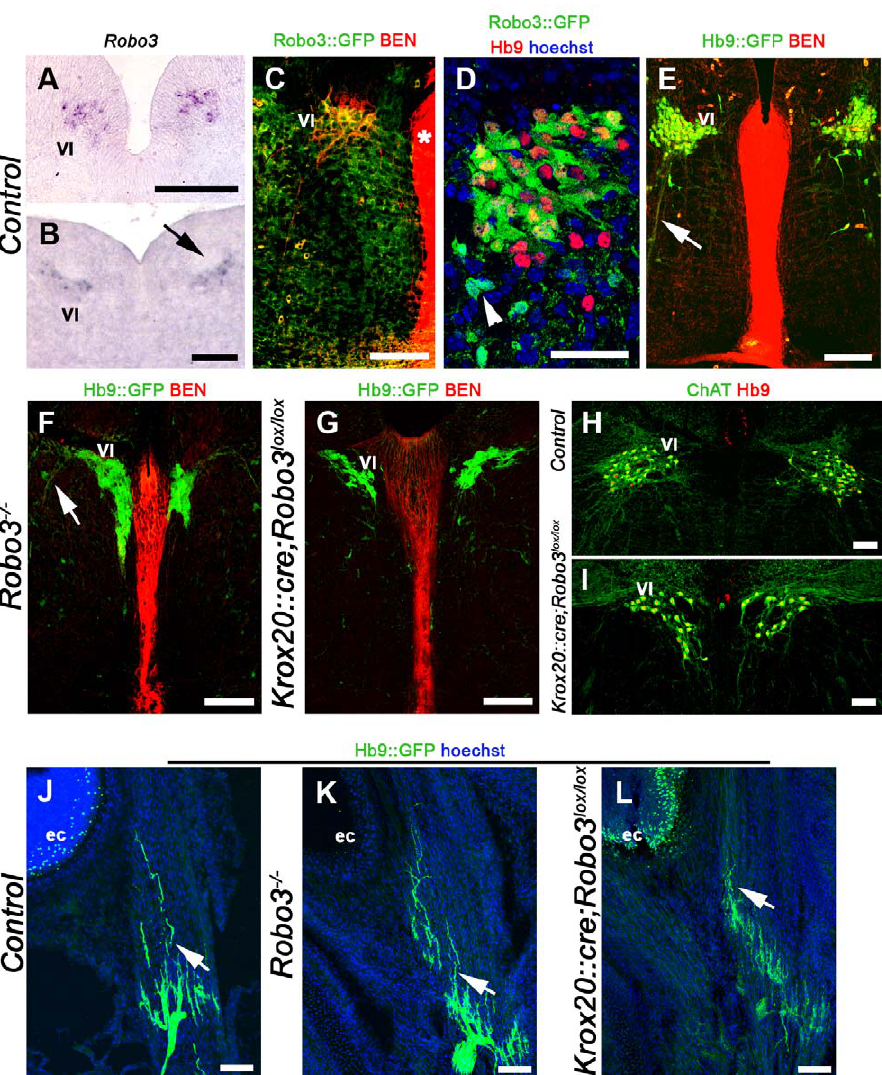
Figure 3. Normal projection of abducens motor axons in Robo3-deficient mice. (A to I) show coronal hindbrain sections at the level of the abducens nucleus. (A and B) Robo3 transcripts are detected in the abducens nuclei of E12 (A) and E14 (B) embryos. The arrow in (B) points to the facial nerve. (C) abducens neurons coexpress BEN and GFP in Robo3 + / 2 E14 embryo. The floor plate (asterisk) also expresses BEN. (D) Hb9/GFP double labeling in E15 Robo3 + / 2 embryo. Note that some GFP + cells (arrowhead) do not express Hb9. (E) abducens neurons (VI) and axons (arrow) express GFP in E14 Hb9::GFP transgenic embryo. (F–I) The abducens nucleus has an abnormal shape and is closer to the floor plate in Robo3 2 / 2 (F) and Krox20::cre;Robo3 lox/lox (G) E14 embryos (compare with [E]). The arrow in (F) points to abducens axons. (H and I) This abnormal shape and position are also observed in adult animals with ChAT/Hb9 double immunostaining. (J to L) Coronal sections of P0 mouse head at eye cup (ec) level. GFP-positive abducens axons (arrows) still contact the lateral rectus muscle in Robo3 -null embryo (K) and Krox20::cre;Robo3 lox/lox mutant (L). Scale bars represent 100 m m, except in (D), where it indicates 50 m m.